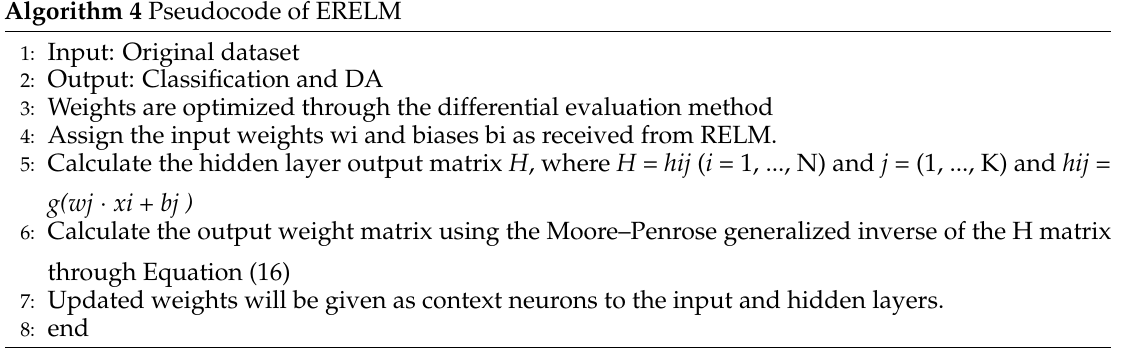
Algorithm 4 Pseudocode of